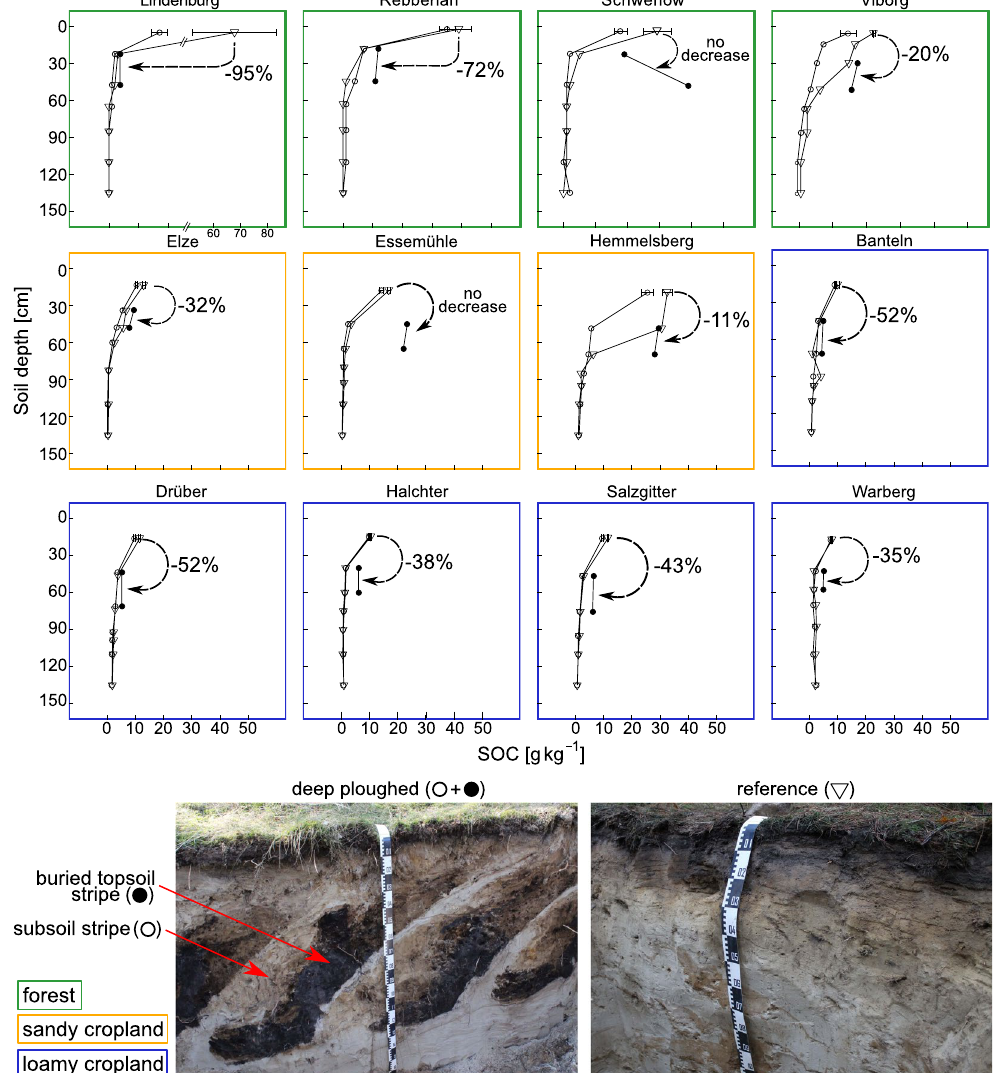
Figure 1. Depth distribution of mean SOC content in deep-ploughed ( ⚬ • ) and reference plots (  ). Topsoil SOC content in soil profiles and cores (N = 6). Deep-ploughed plots consist of alternating buried topsoil ( • ) and subsoil stripes ( ⚬ ). Dashed arrows and percentages indicate the relative difference between average topsoil SOC and average SOC in buried topsoil